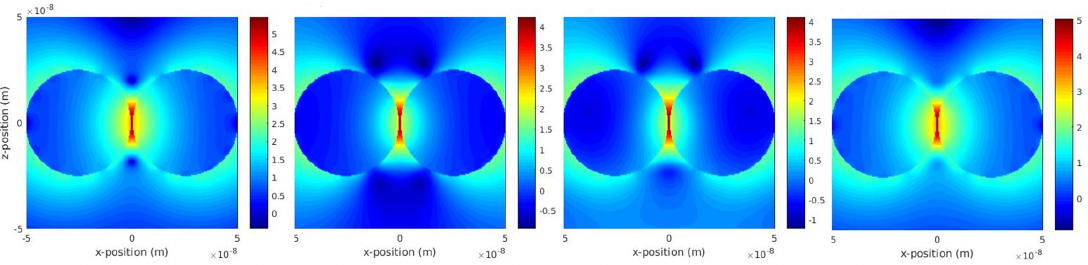
Figure 7. Scattering efficiency for Ag, Au, Al and Cu dimers (left to right) with radius a = 25 nm embedded in water and varying particle separation. Excitation polarisation is parallel to the dimer axis.